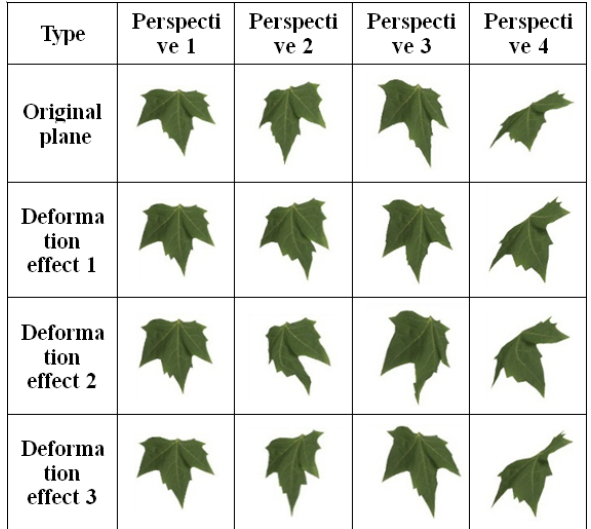
Figure 2. Figure placement and numbering